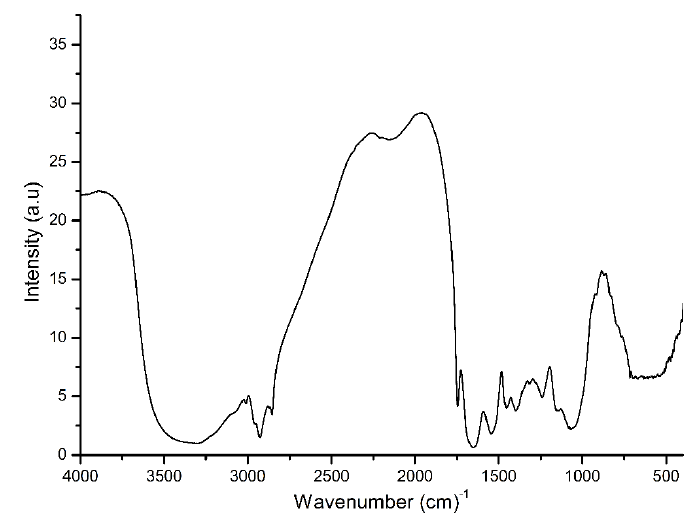
Figure 1. FTIR spectrum in transmission mode of fenugreek seeds.